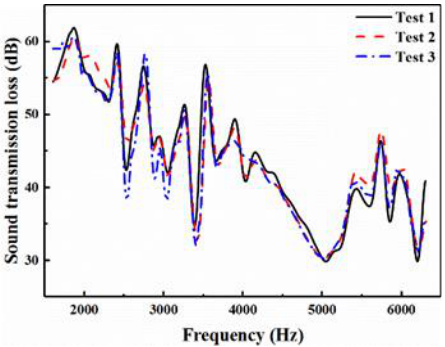
Figure 9. Test reproducibility results for an A2-type panel.